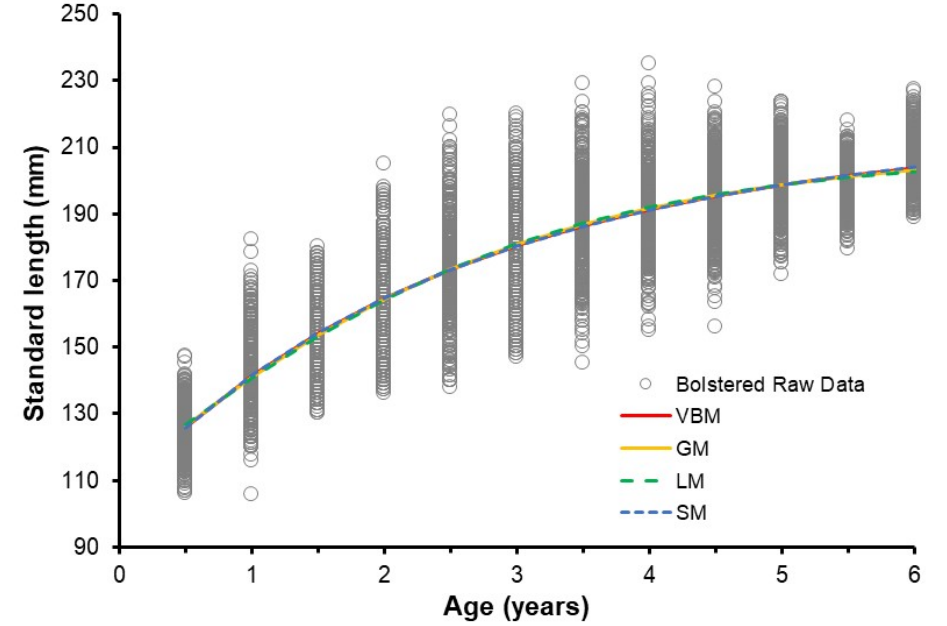
Figure 7. Growth models adjusted to age-at-length data bolstered of the temperate Sardinops sagax stock in the southern California Current System (CCS) during study period (2005–2014).